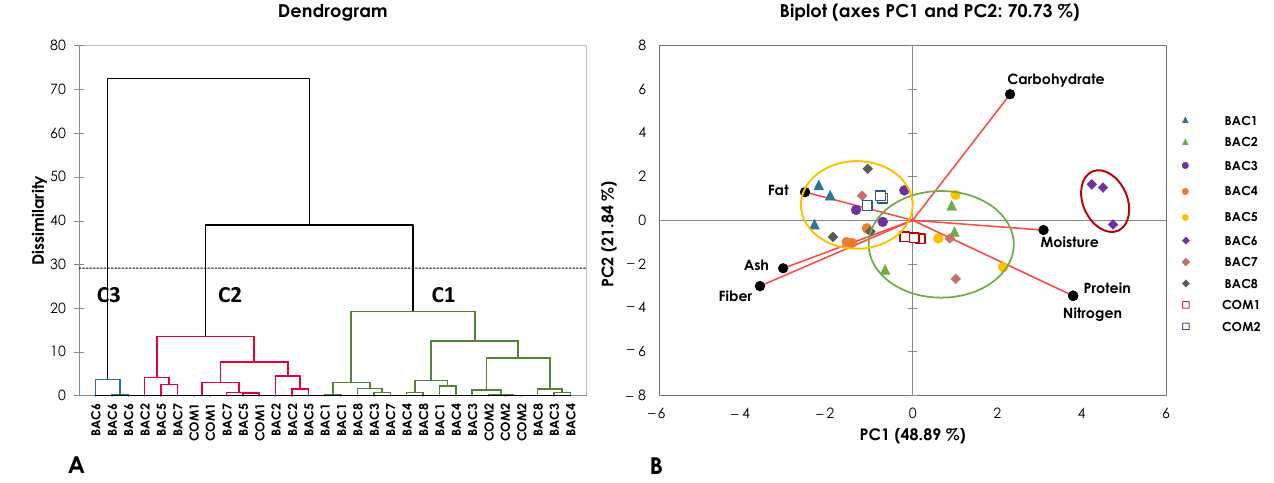
Figure 3. ( A ) The dendrogram of di ff erent Gymnema inodorum samples assessed from their proximate compositions. ( B ) The principal component (PC) analysis of the G. inodorum based on their proximate compositions. C1–C3 represent di ff erent clusters displayed on the dendrogram ( A ), and the same clusters (color) are shown in the biplot ( B ).